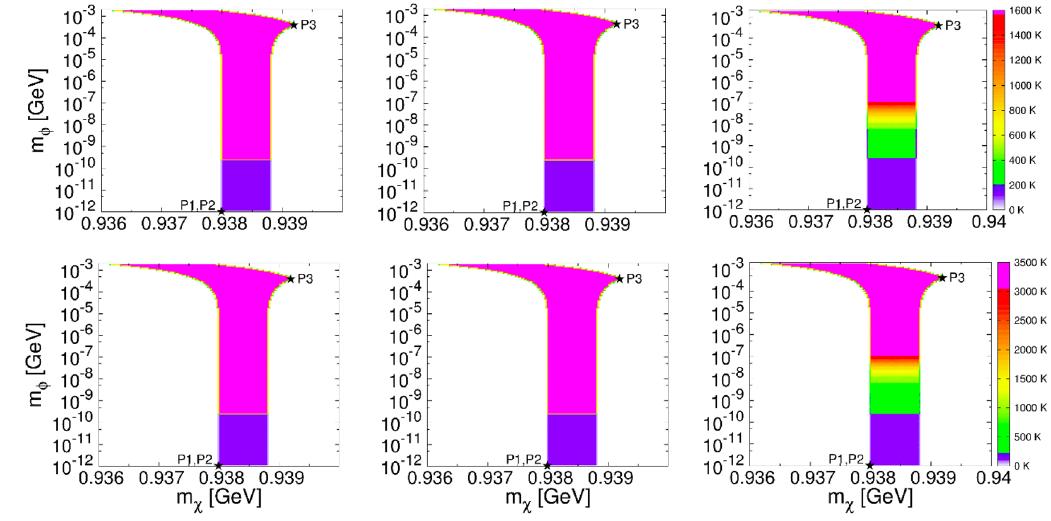
Figure 9 . Same as (cid:12)gure 8 but (cid:22) (cid:31) is DM. Upper-row: (cid:30) decay (cid:12)nal states cannot be absorbed by the NS. Lower-row: (cid:30) decay (cid:12)nal states are absorbed by the